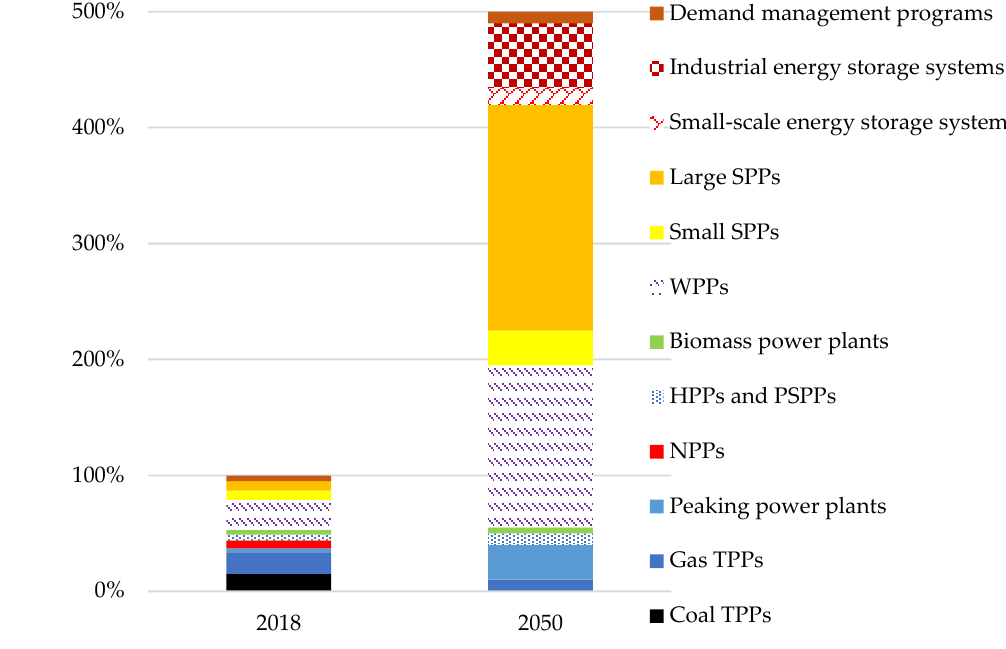
Table 2. Tools to enhance the flexibility of energy systems